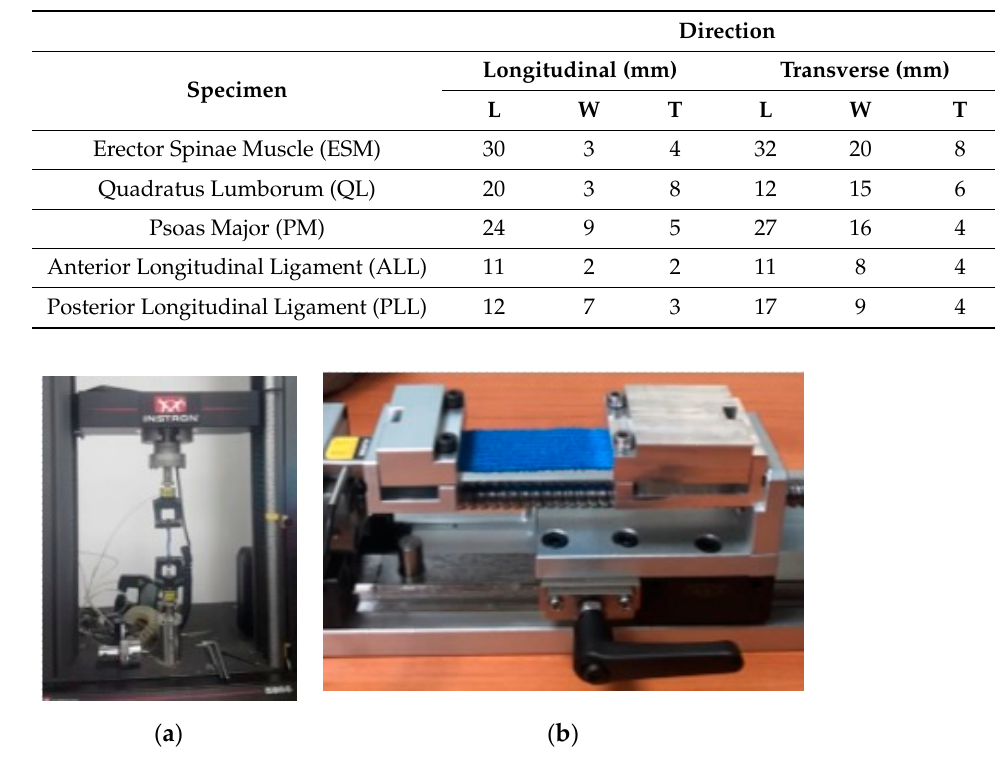
Table 1. Sample dimension. L denotes length, W denotes width, and T denotes a thickness.